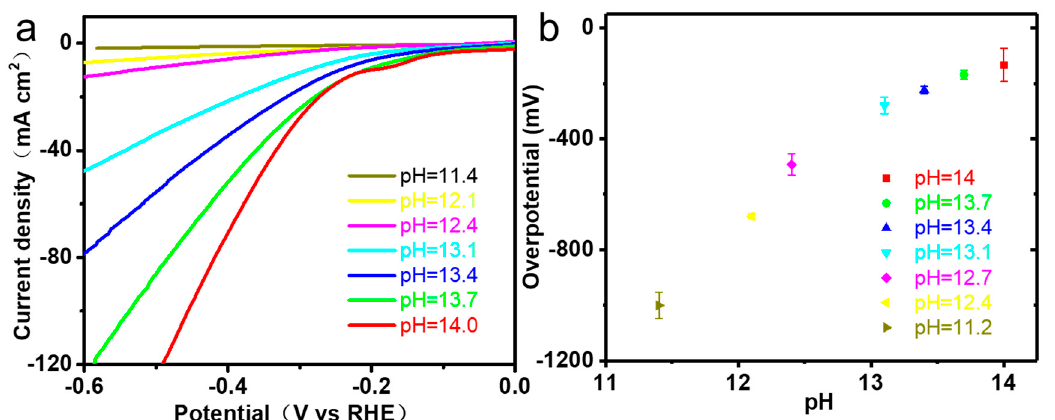
Figure A1. ( a ) and ( b ) SEM images of Co-FeS 2 /CoS 2 nanowires.